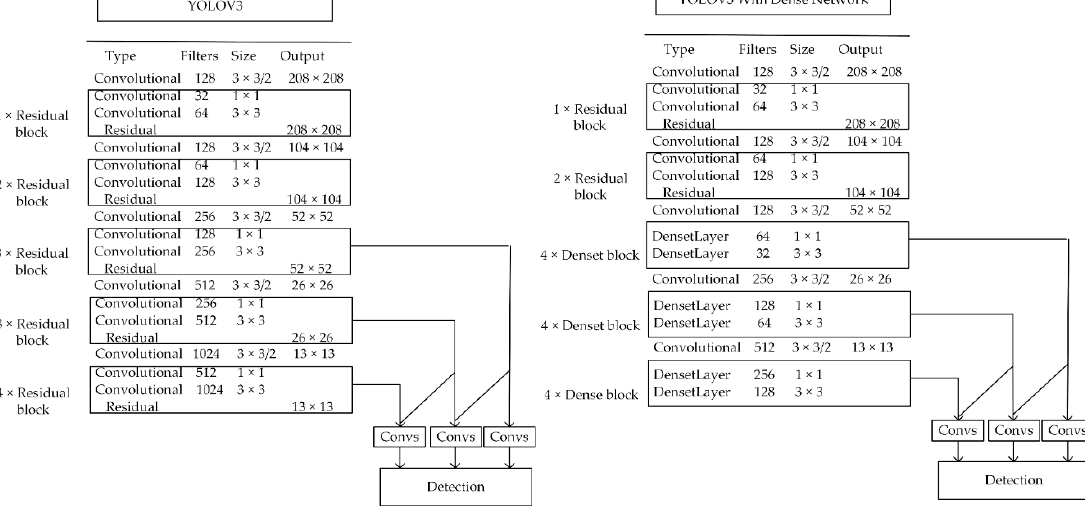
Figure 7. YOLOv3 model and YOLOv3 with dense network.